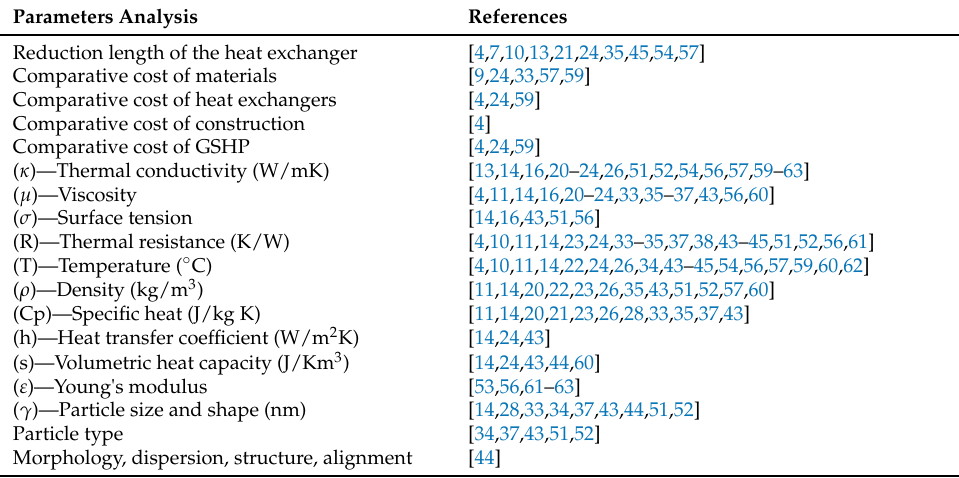
Table 6. Summary of parameters and analysis in heat